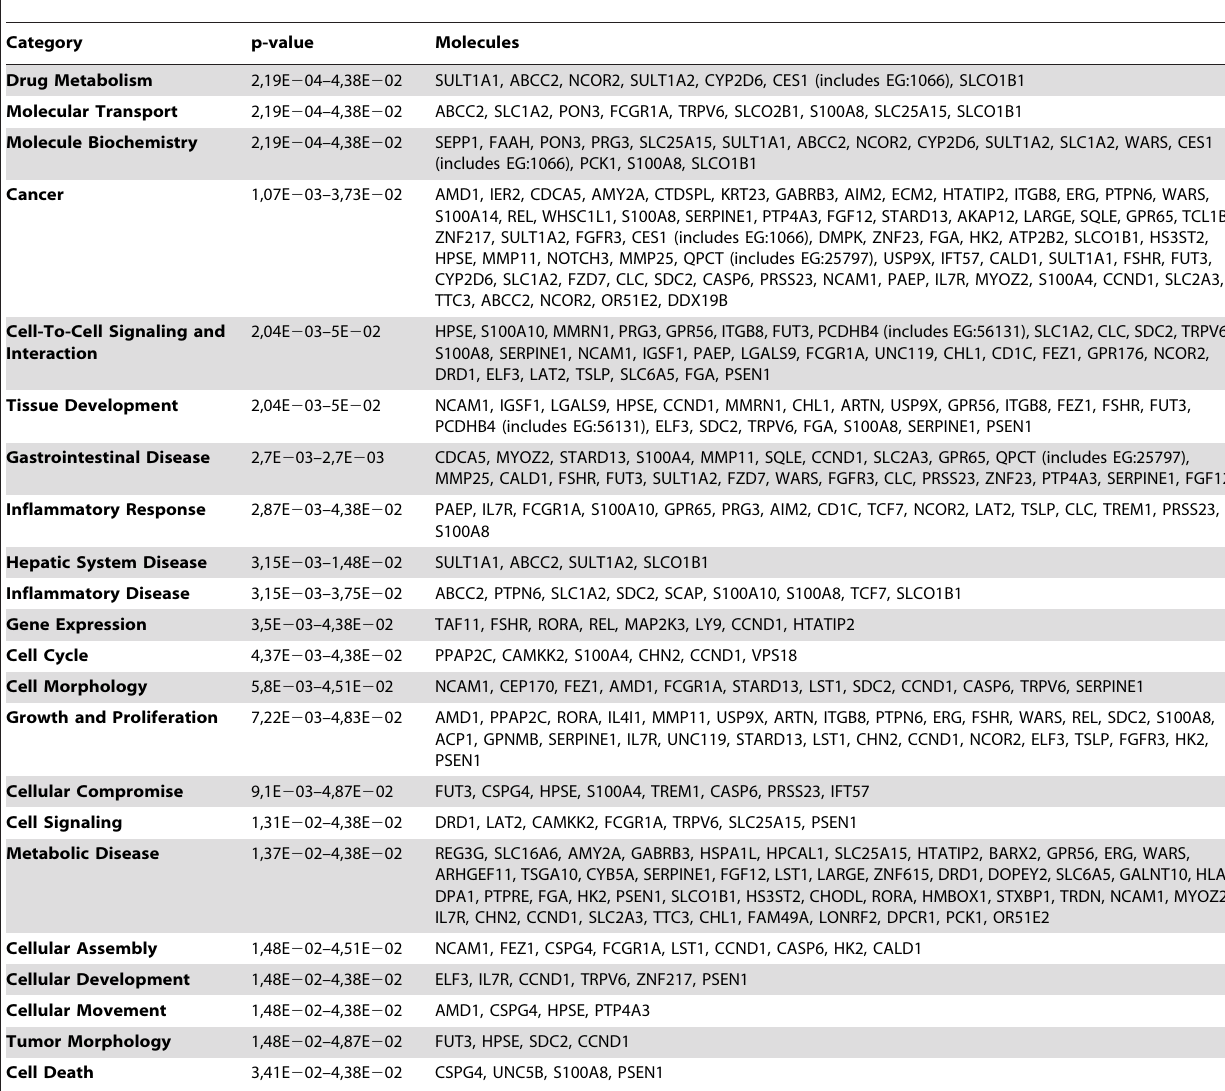
Table 1. Functional categories of curcumin mediated genes in HCT116 colon cancer